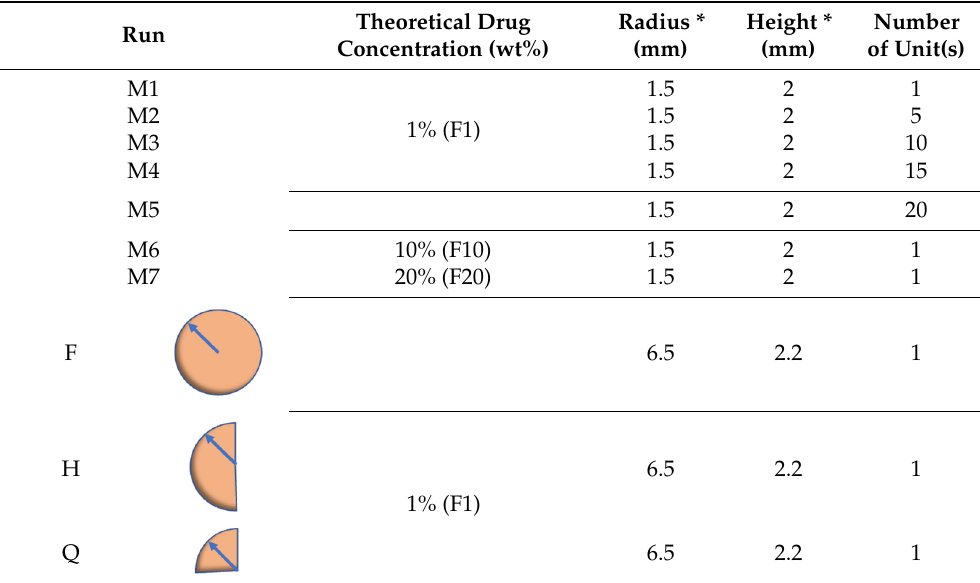
Table 2. Tablet size and number of unit(s) of the printed